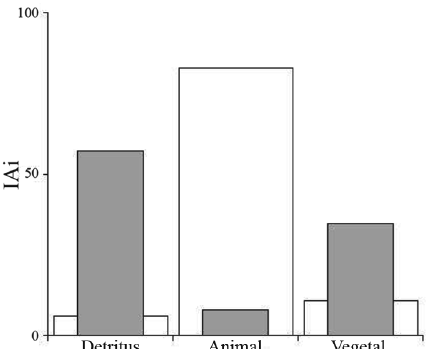
Fig. 1. Comparison between juvenile (white) and adult (grey) alimentary index (IA ) of each food category consumed by i Phalloceros anisophallos from córrego Andorinha (Ilha Grande, Rio de Janeiro).